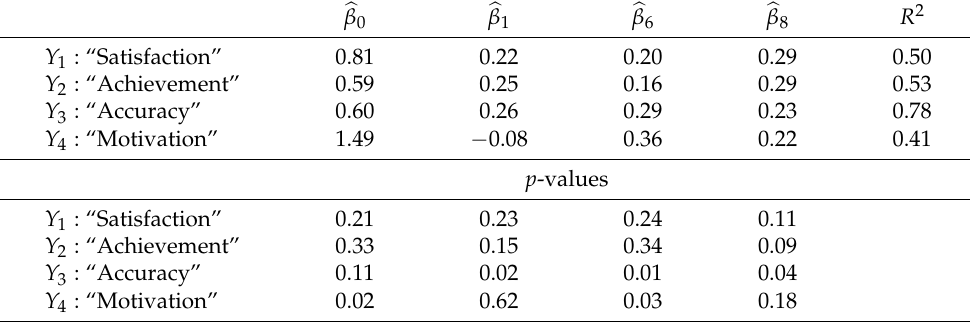
Table 4. Estimated parameters, corresponding p -values, and coefficient of determination R 2 in the regression of performance measures ( Y 1 , . . . , Y 4 ) on selected key identified performance measure variables ( X 1 , X 6 , X 8 ) for employees in the banking